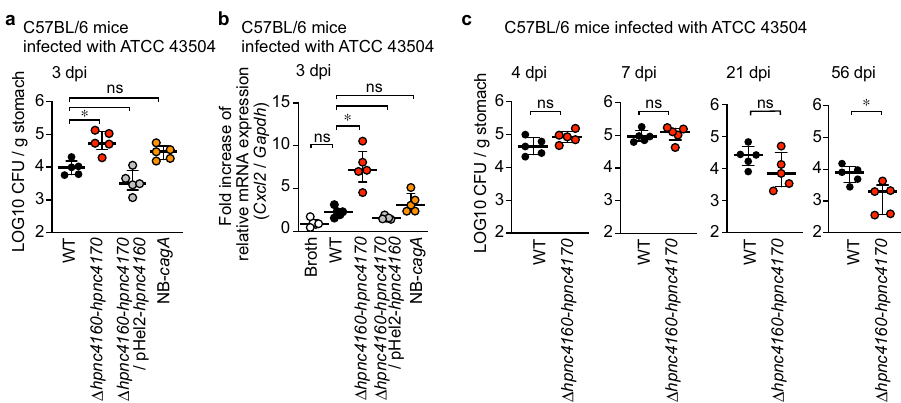
Fig. 4 HPnc4160 regulates bacterial-host adaptation and pathogenesis. a , b Three days after infection, quantitative culture assays ( a ) and RT-PCR ( b ) were performed on mouse gastric specimens. c Effect of HPnc4160 deletion of H. pylori on bacterial load in mouse stomach at indicated days of post infection (dpi). Statistical signi fi cance determined by non-parametric Dunn ’ s multiple comparison test (two-sided) ( a , b ) or two-tailed Mann – Whitney test ( c ). * P = 0.0485 ( a ); * P = 0.0309 ( b ); * P = 0.0159 ( c ); ns, not signi fi cant. Source data are provided as a Source Data fi